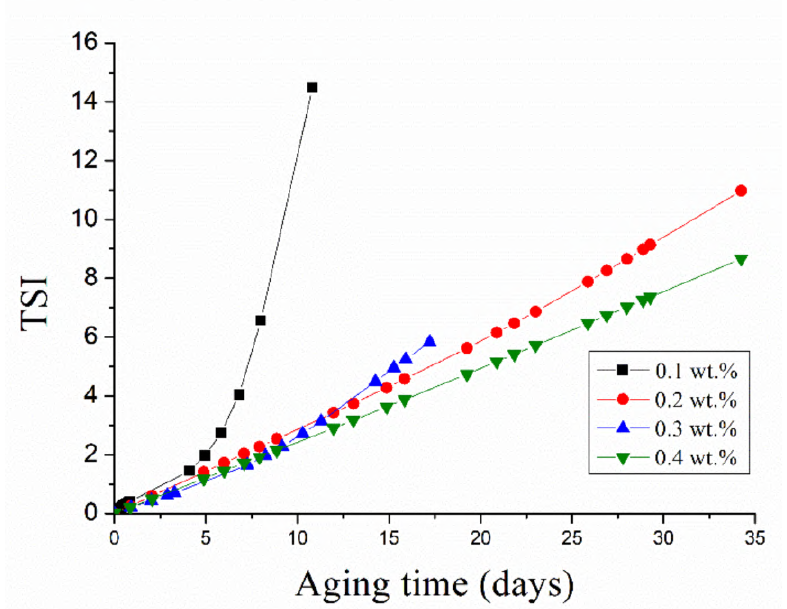
Figure 7. Influence of aging time on Turbiscan stability index as a function of diutan gum concentra- tion for the emulsions